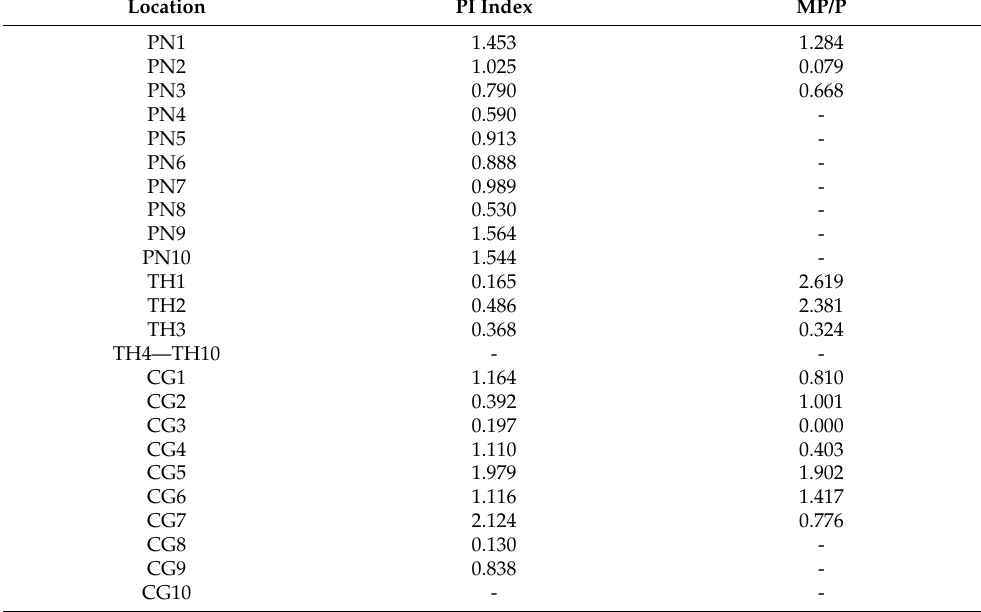
Table 3. Pyrogenic index values and methyl phenanthrene-to-phenanthrene (MP/P) ratios of poly- cyclic aromatic hydrocarbons detected in PM 2.5 samples collected in Hanoi,